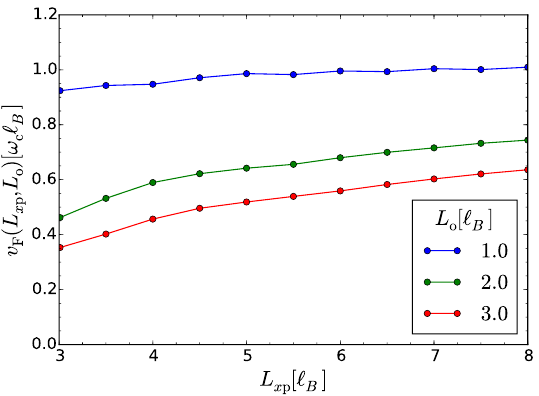
Figure 12: Fermi velocity v for various bay openings L